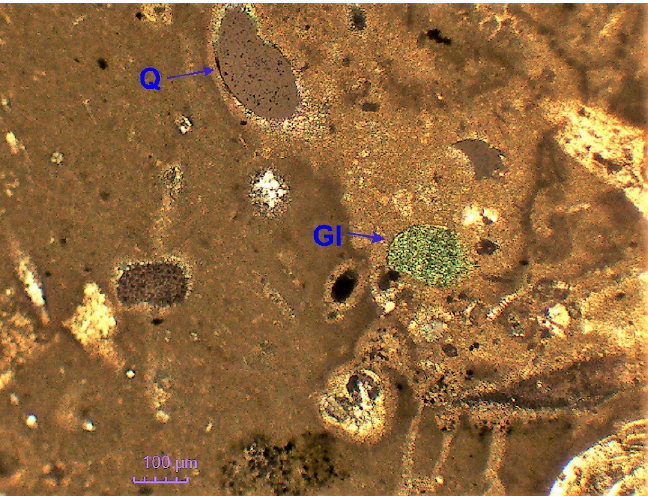
Figure 5. Micrite-organic structure of opoka rocks. Polarizing microscope, Xp. Xp—crossed polarizers, Q -quartz, Gl—glauconite.